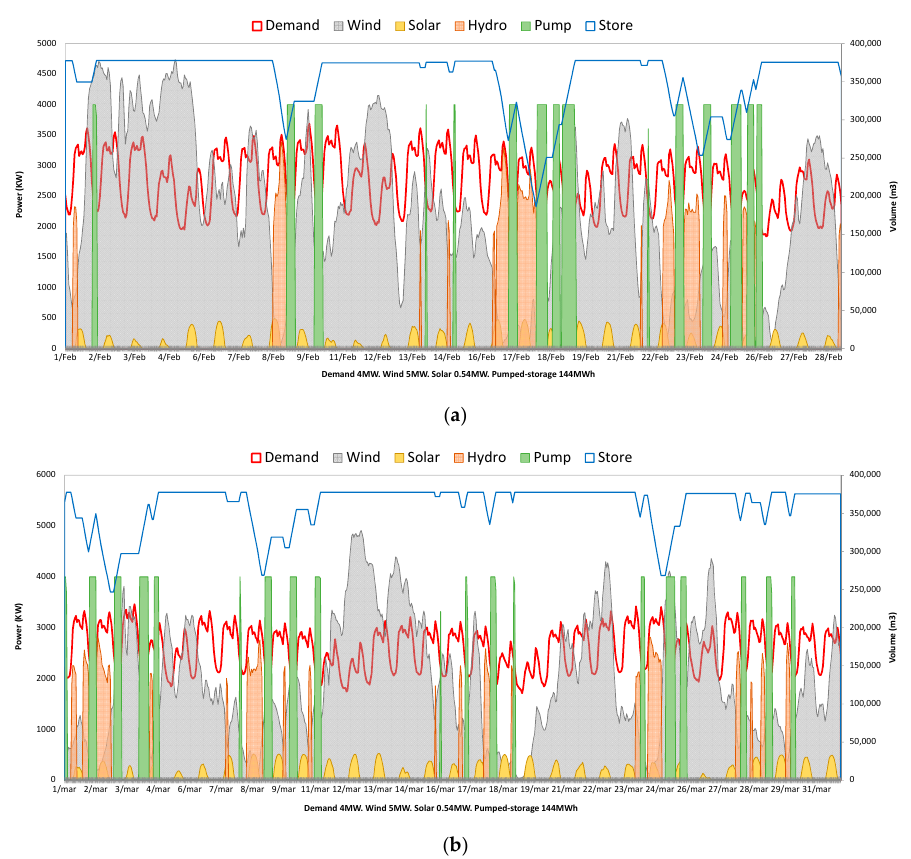
Figure 9. Electricity generation and stored in scenario 2 between February ( a ) and March ( b ).